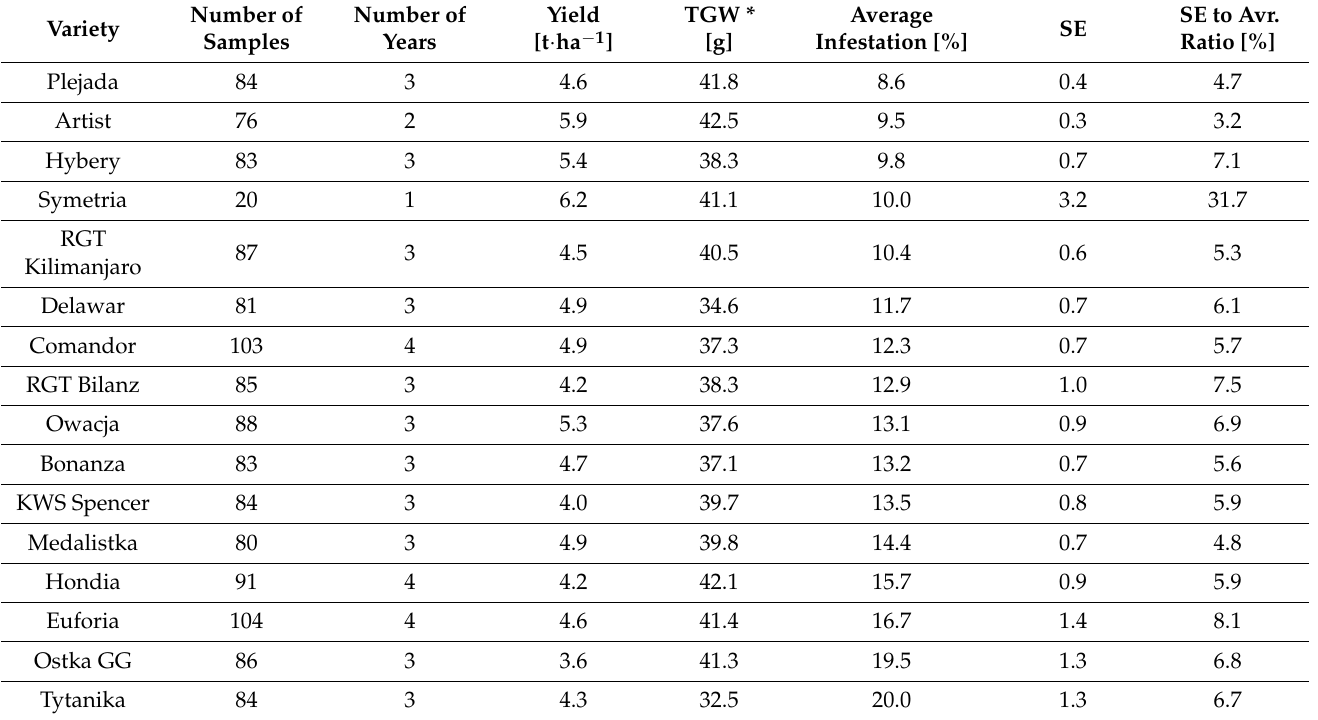
Table 9. List of tested varieties ranked by lowest average fungal disease